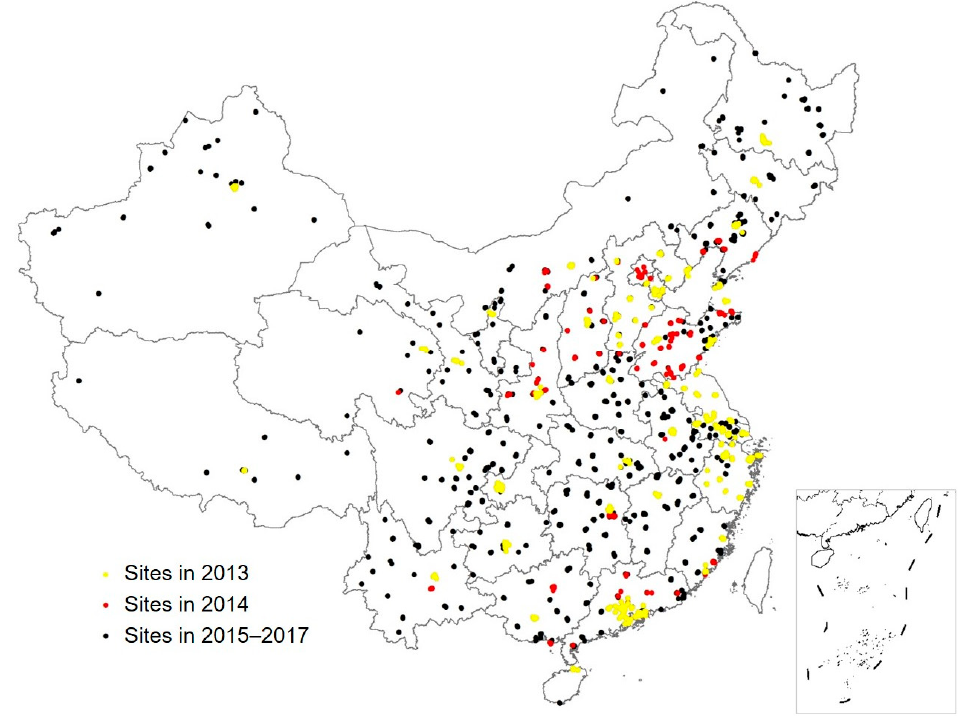
Figure 1. In situ surface PM 2.5 measurement sites in 2013 (yellow circles), 2014 (red circles) and 2015–2017 (black circles) used in this study. 2015–2017 (black circles) used in this